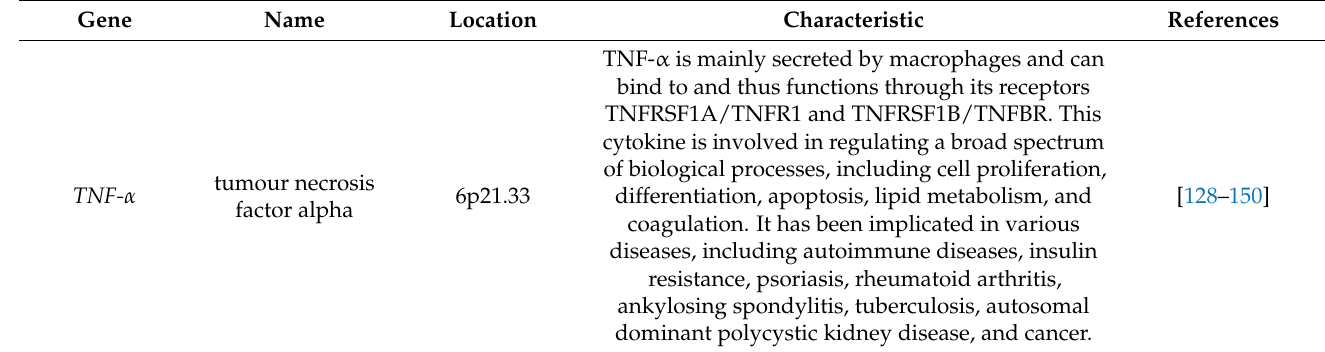
Table 4. Characteristic of cytokines associated with bladder